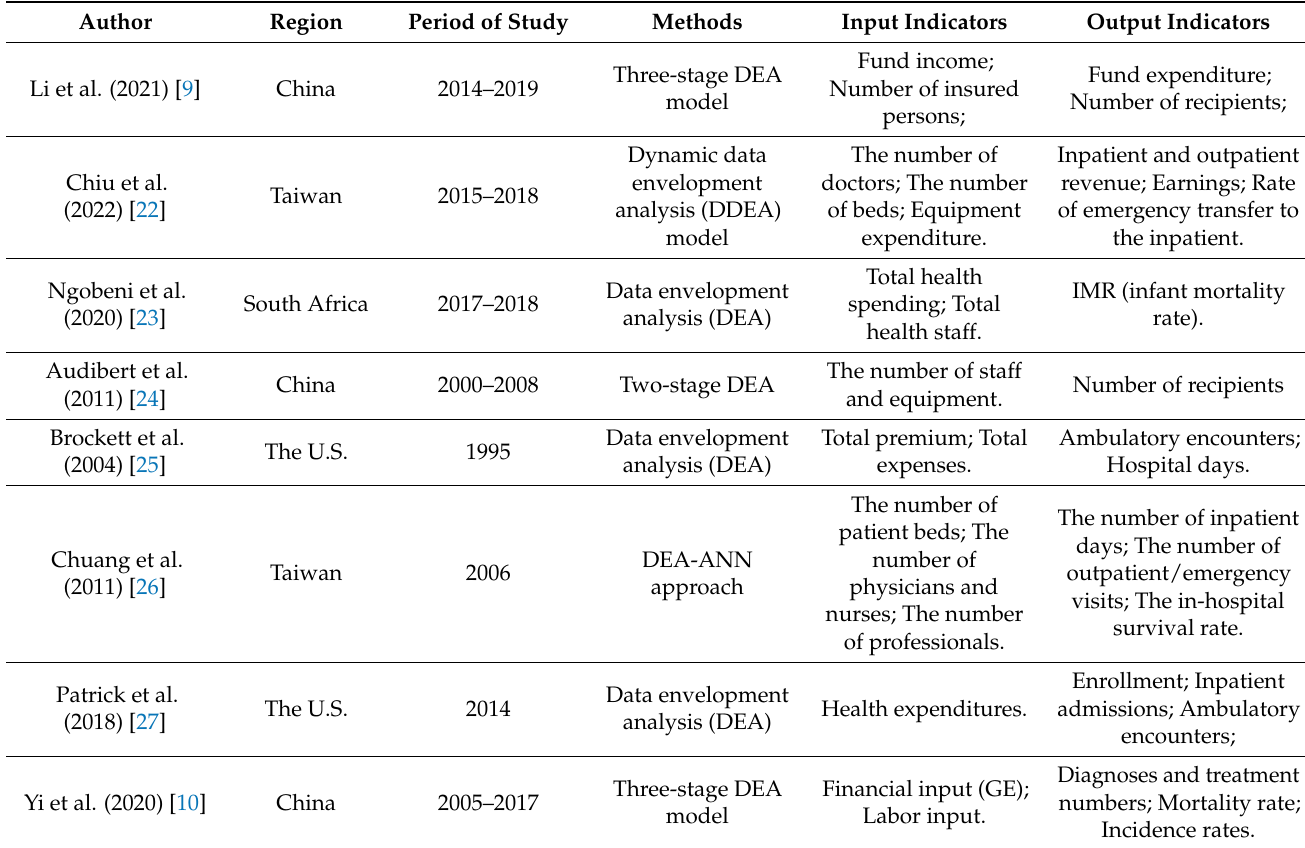
Table 1. Summary of the Input and Output Indicators about the Health Service